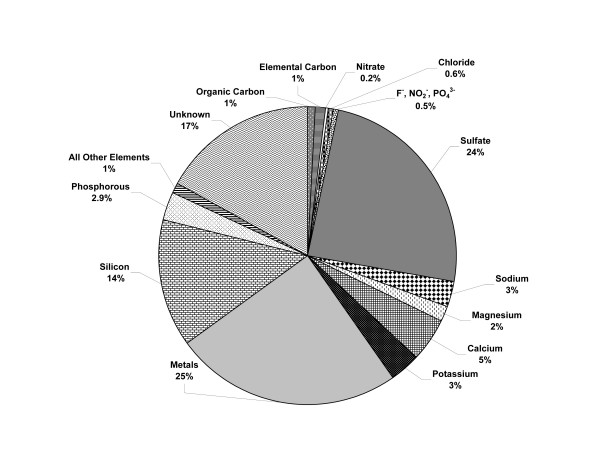
Chemical composition of HP12 by percent of total mass. Determination of constituents was conducted using X-ray fluorescence, carbon fractionation, inductively-coupled plasma optical emission spectrometry, and ion chromatography. The metals category includes Al, Cu, Fe, Mg, Ni, V, and Zn. The unknown portion is likely comprised of moisture, along with oxygen and hydrogen associated with organic and inorganic fractions [14].